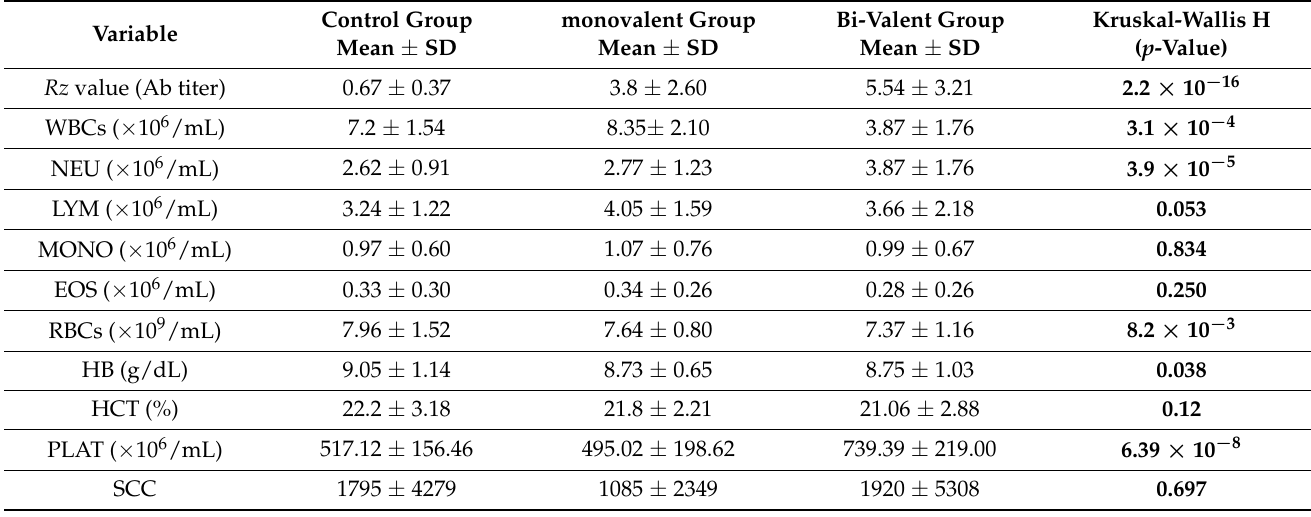
Table 1. Results of the statistical analysis of the estimated variables (Ab titer, hematological parame- ters, and